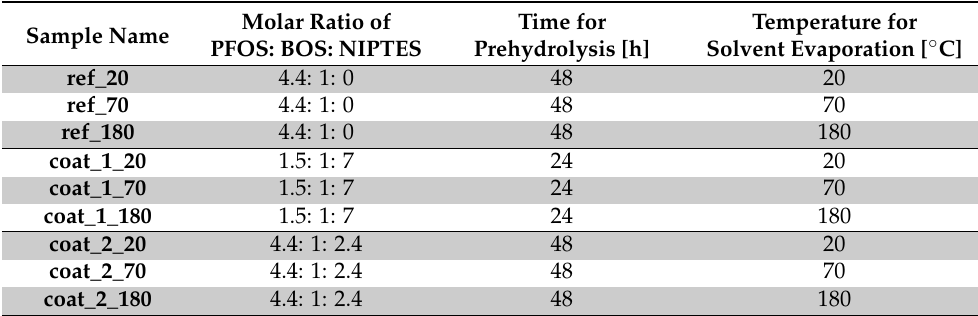
Table 1. Chemical composition of and preparation conditions for all prepared